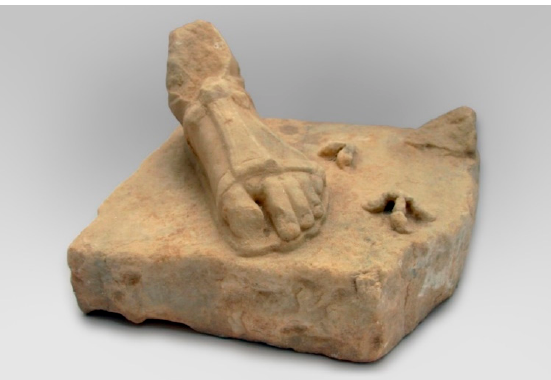
Figure 12. Two claws with part of bird’s tail beside human foot in sandal (MGW inv. no. 5419); marble sculptural pedestal; Roman period.